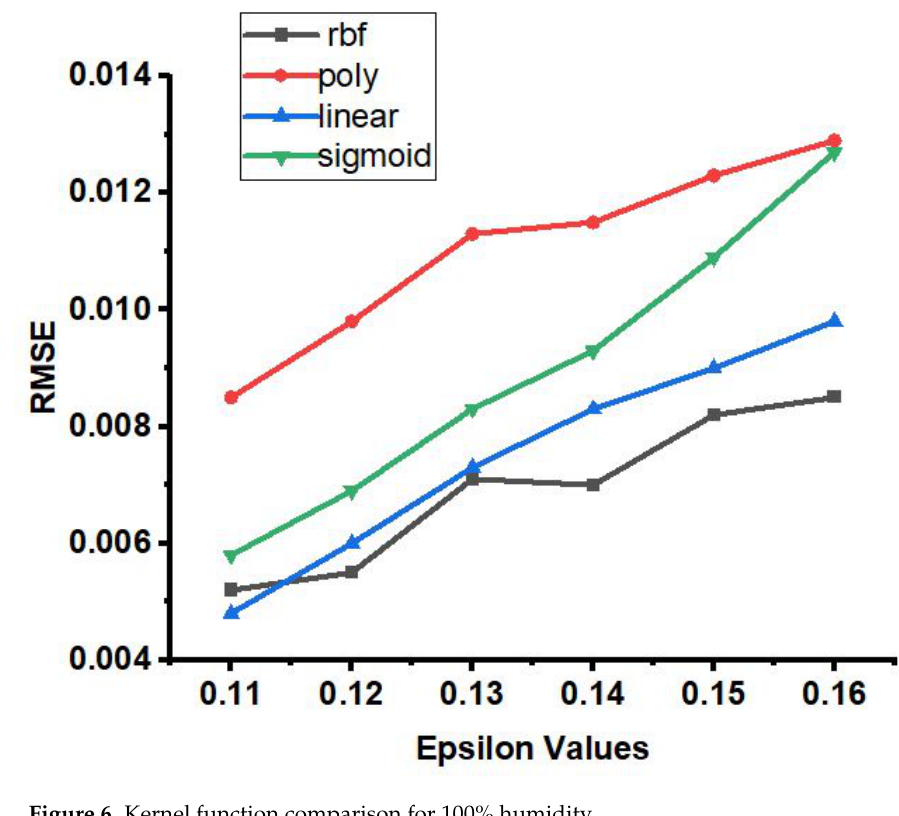
Figure 6. Kernel function comparison for 100% humidity.